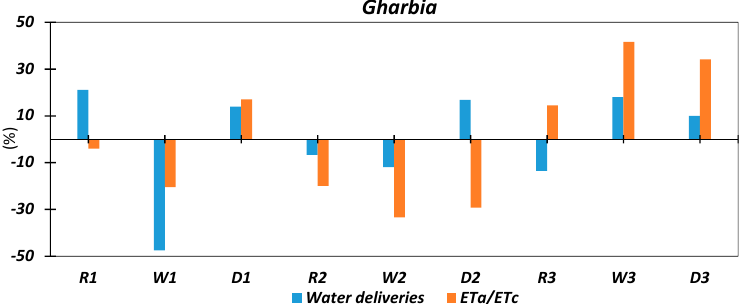
Figure 13. Gharbia district; relative anomalies in quarterly water delivery W d and relative evapotranspiration ET a / ET c ; 1,2,3 and R, W, D: see Figure 6.